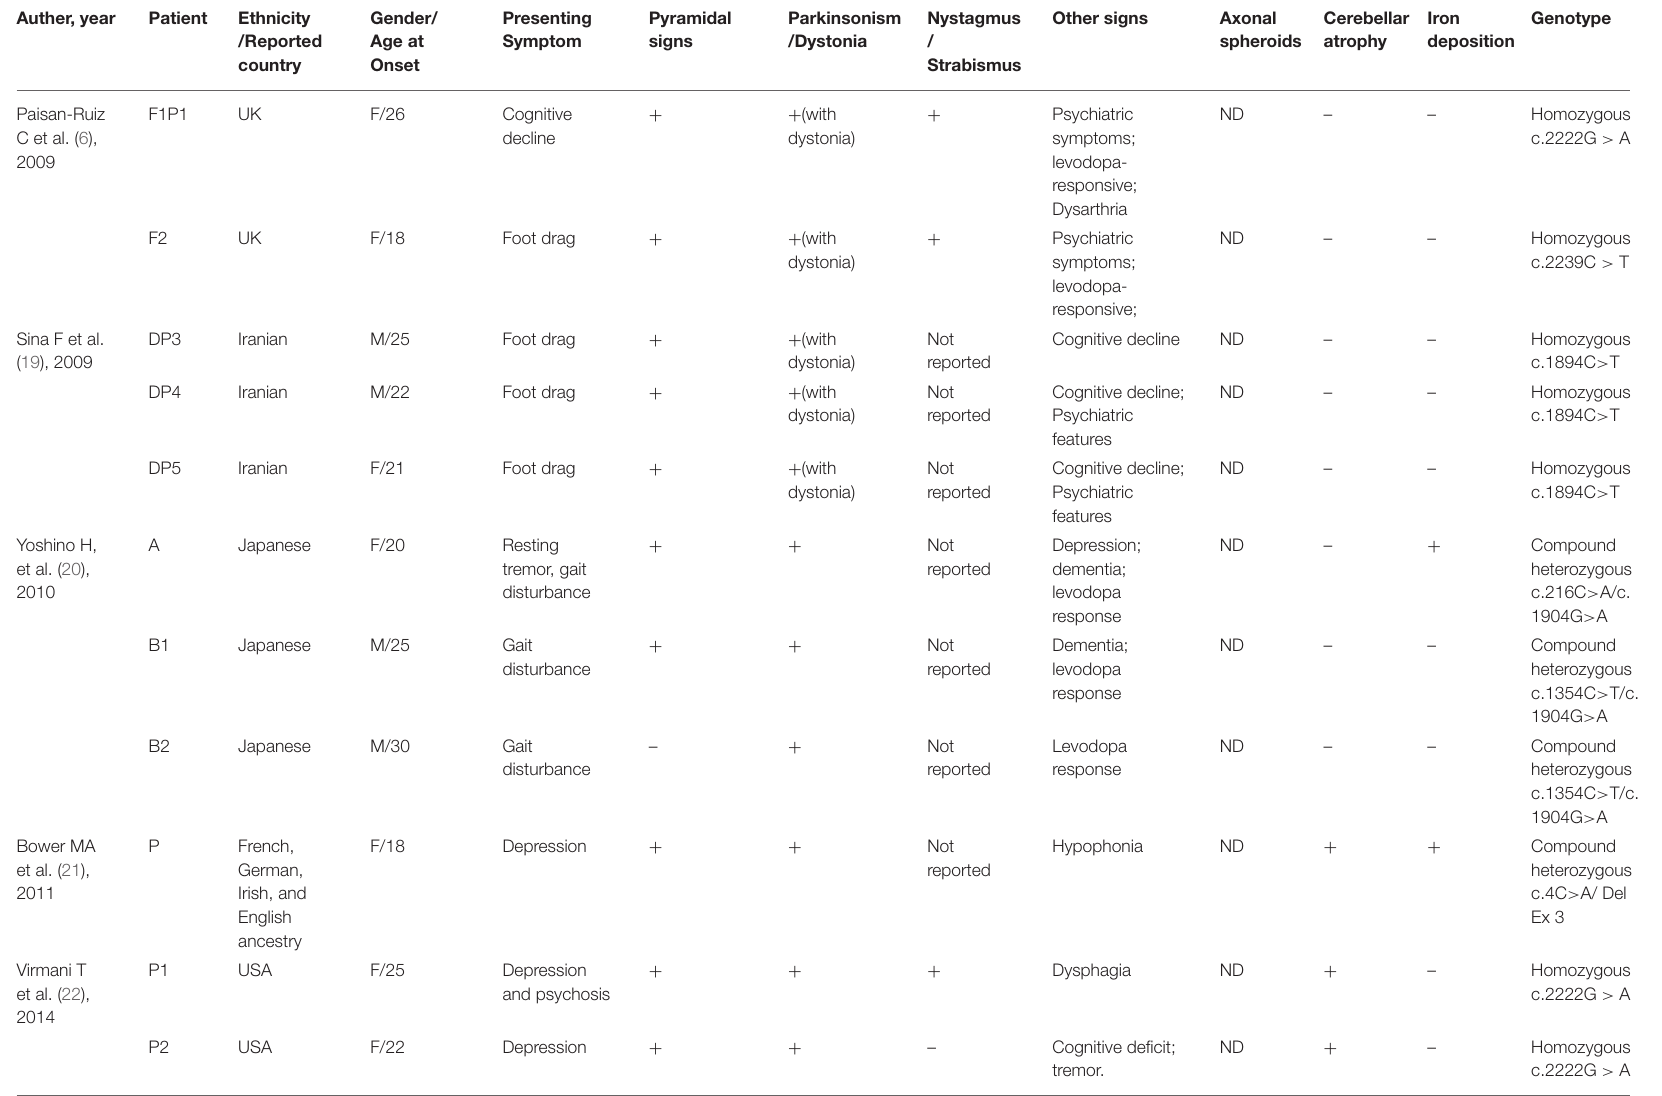
TABLE 3 | Summary of demographic and clinical findings of reported 34 adult onset PLA2G6 -related parkinsonism patients. Auther,